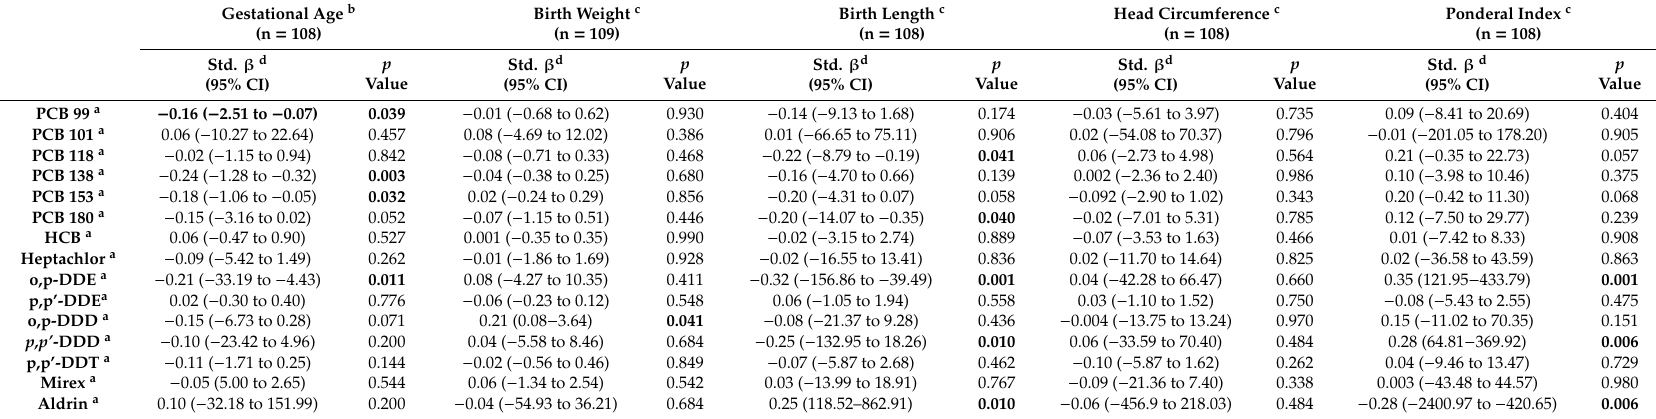
Table 4. Multivariable linear analysis of selected POPs and pregnancy outcomes; adjusted for maternal age, parity, BMI, residential area, education and